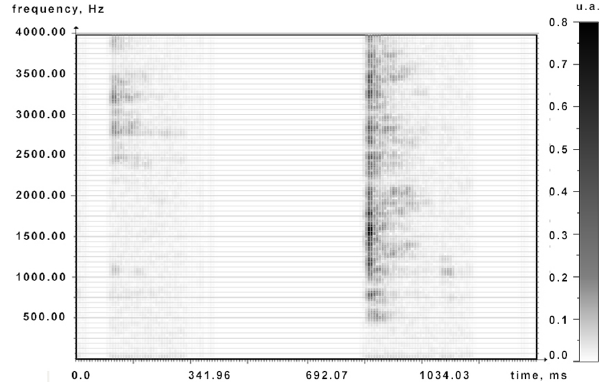
Figure 8. An EM signal registered during the granite sample frac-